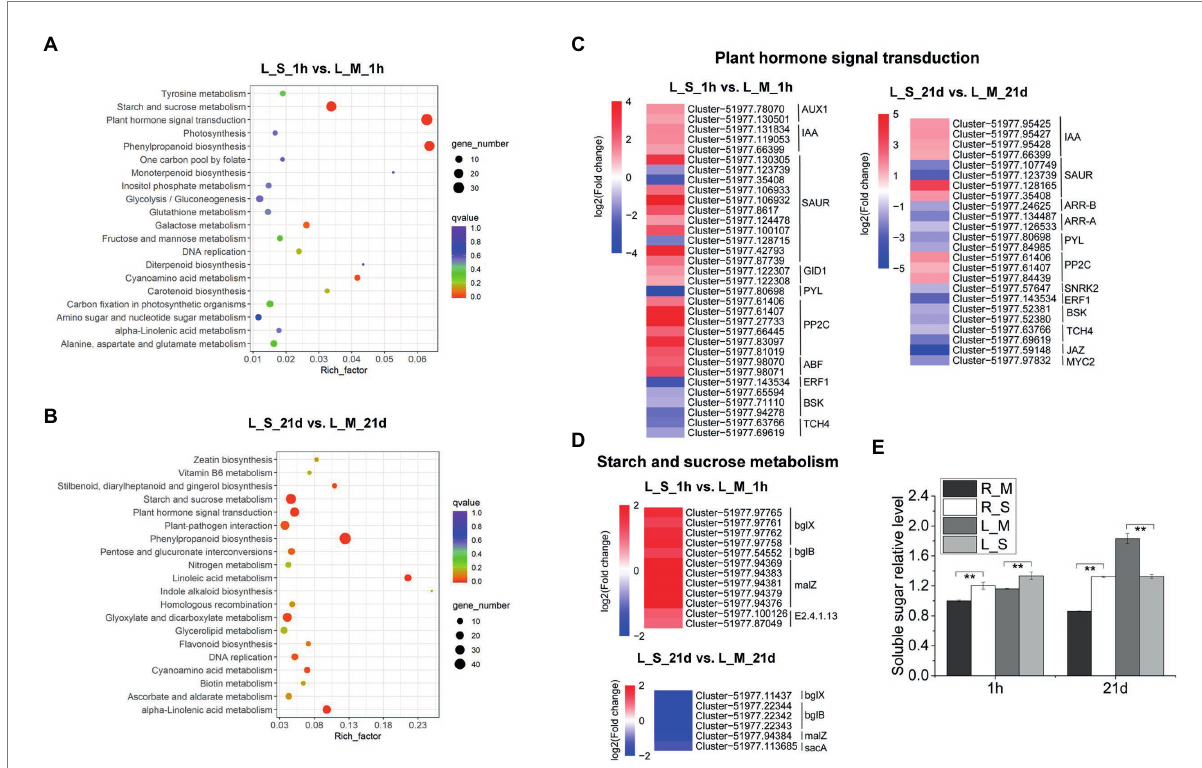
FIGURE 6 KEGG analysis of DEGs in leaves and expression analysis of DEGs involved in “plant hormone signal transduction” and “starch and sucrose metabolism.” (A) The top 20 pathways that were significantly enriched in leaves of plants after 1 h of salt treatment (400 mM Na). (B) The top 20 pathways that were significantly enriched in leaves after 21 days of salt treatment. (C,D) Expression analysis of DEGs in leaves involved in “plant hormone signal transduction” and “starch and sucrose metabolism” after 1 h and 21 days of salt treatment. (E) The relative content of soluble sugar content in roots and leaves compared to the R_M sample. R_M and L_M mean roots and leaves of plants untreated with Na. R_S and L_S mean roots and leaves of plants treated with 400 mM Na. The error bars were calculated from three biological replicates. Mean separation was based on Tukey HSD test at p < 0.01 (**)